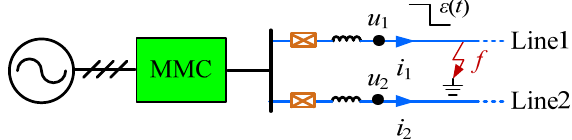
Figure 2. Schematic diagram of the fault section in the VSC-based DC grid.